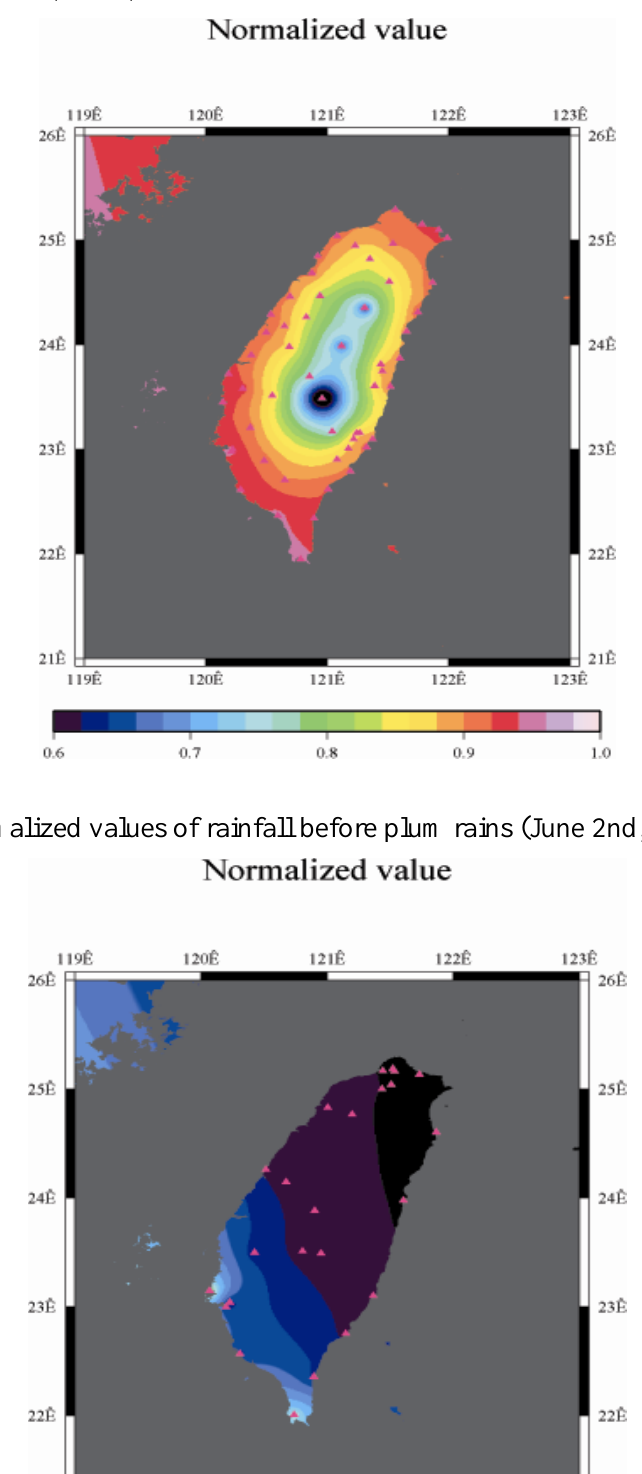
Figure 20. Normalized ZTD values around the island when the plum rains gradually moved north (June 3rd, 2008, 12:00 AM).